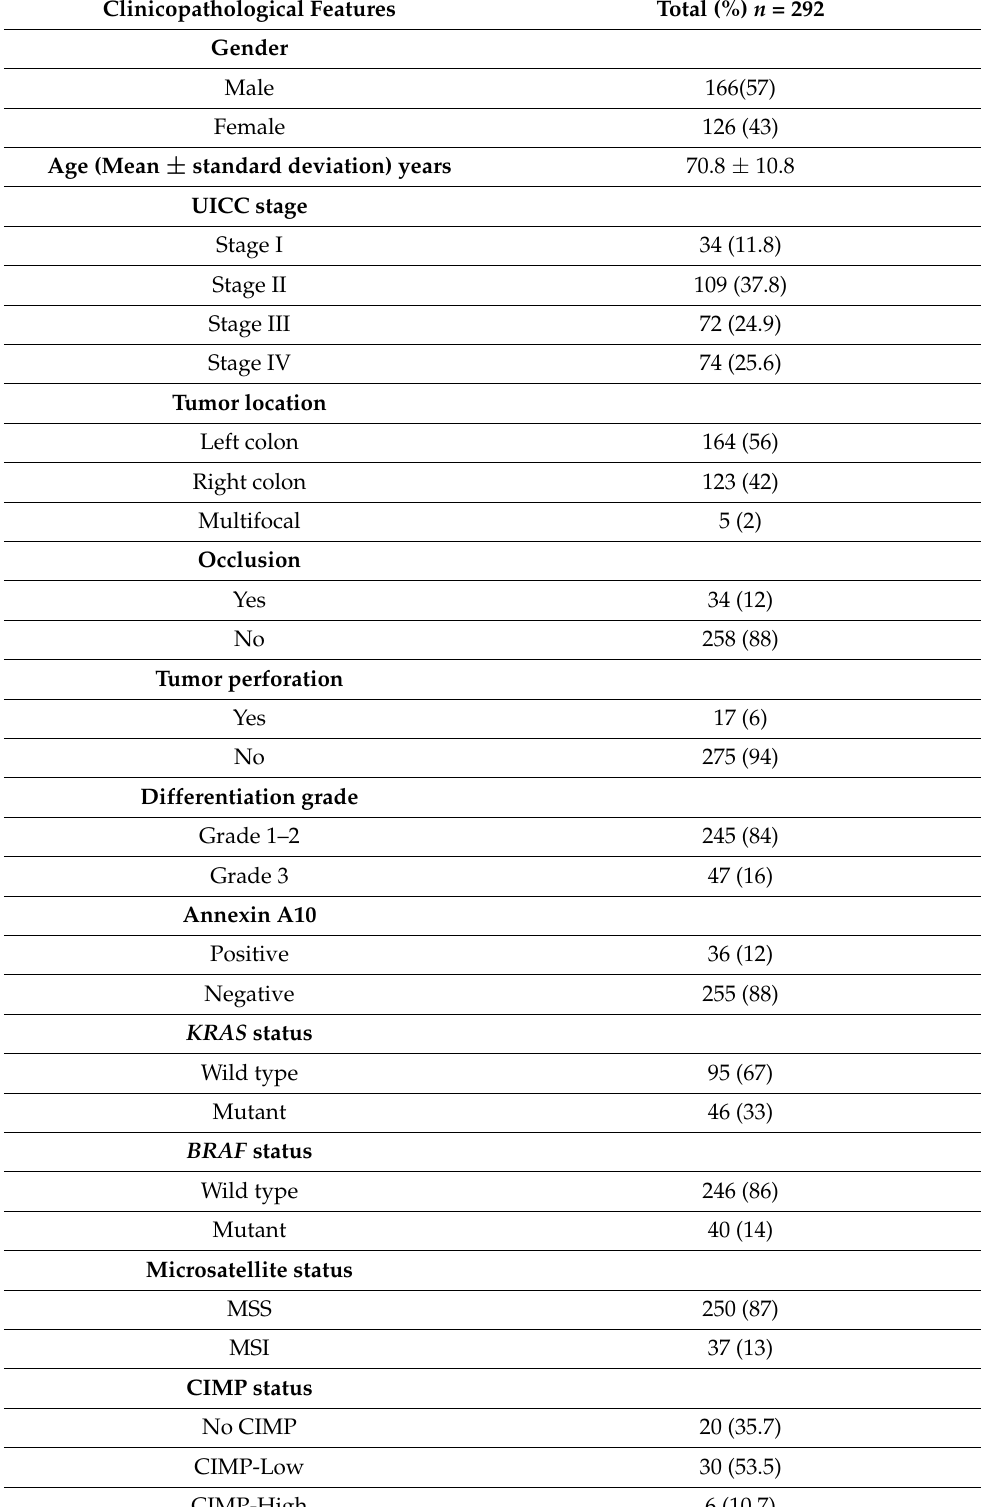
Table 1. Clinicopathological features of the